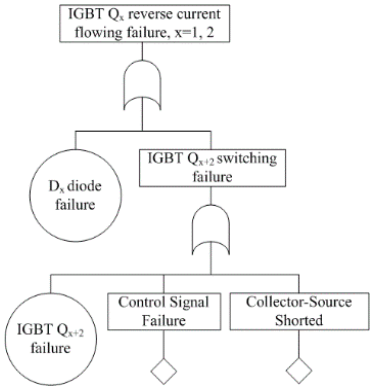
Figure 5. Sub fault tree for insulated gate bipolar transistor (IGBT) Q x reverse current flowing failure, x = 1,2.